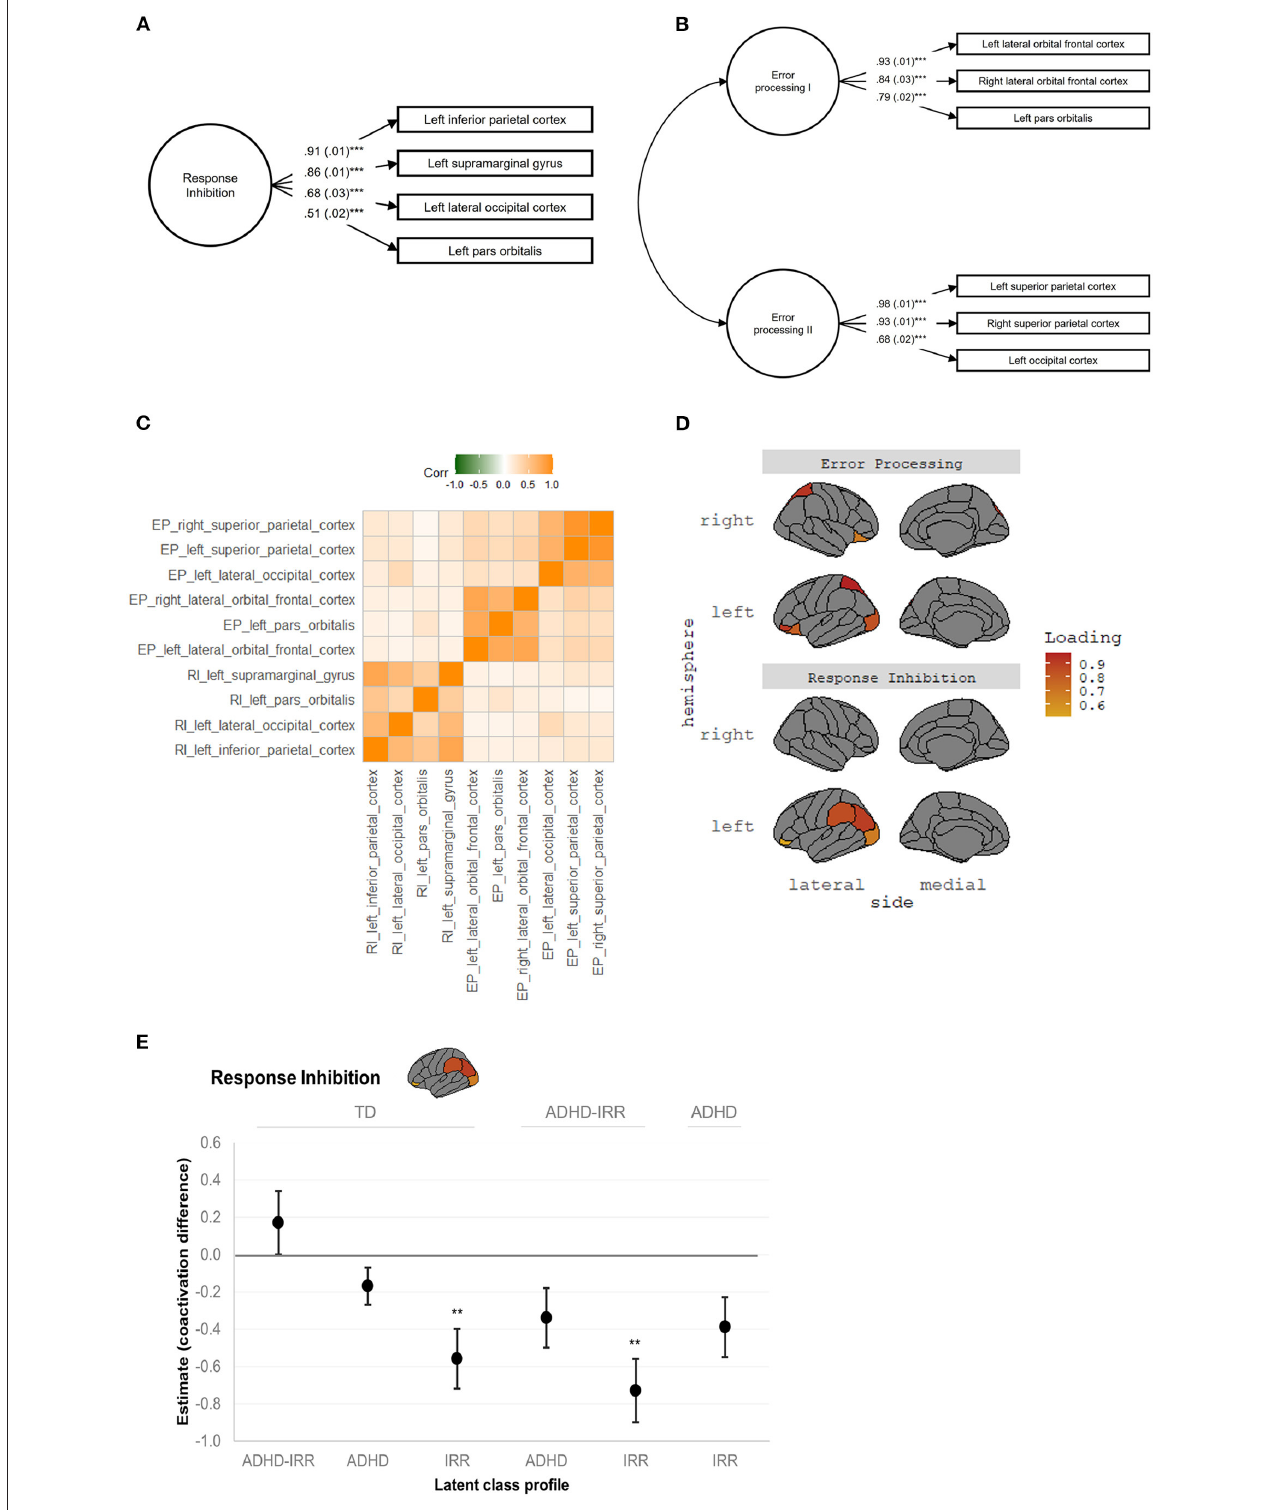
FIGURE 3 | Neural coactivation networks of response inhibition and error processing. RI, response inhibition; EP, error processing. (A) Response inhibition coactivation network and constituent brain regions. (B) Error processing coactivation network and constituent brain regions. Standardized estimates and standard errors were shown in both (A,B) , all *** p s < 0.001. (C) Correlation matrix revealed uniqueness between the latent response inhibition factor and latent error processing